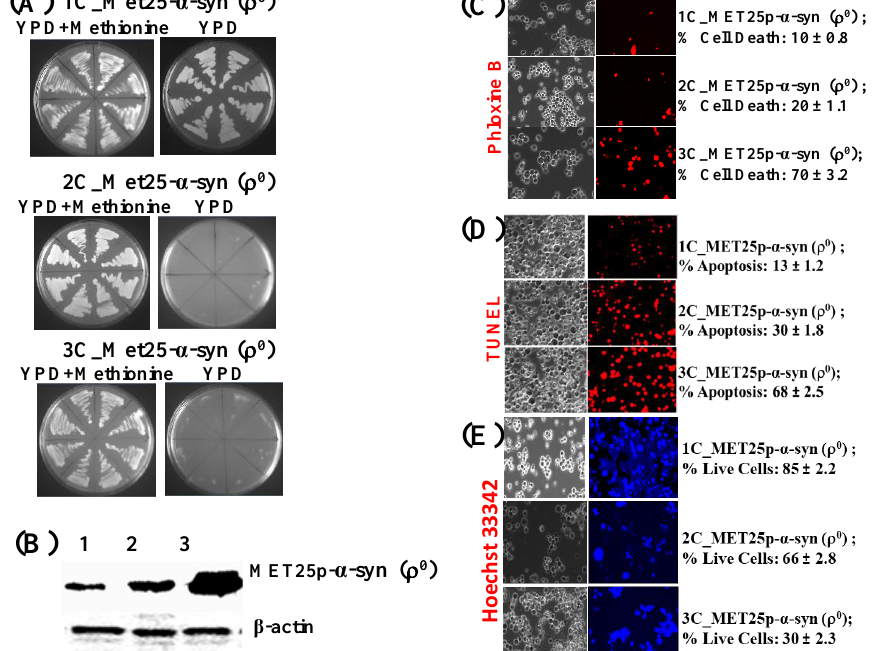
Figure 5. ( A ) Representative pictures of growth of ρ 0 yeast cells harboring 1-copy (1 C ), 2-copies (2 C ), and 3-copies (3 C ) of the human α-syn gene, under the control of either MET25 p, on complete YPD medium agar plates in the presence (YPD + Methionine) or absence (YPD) of methionine. ( B ) Western blot analyses of ρ 0 cells expressing 1-copy (lane 1), 2-copies (lane 2), and 3-copies (lane 3) of α-syn protein. On lanes 1, 2, and 3 were loaded 7.5 µg of total protein obtained after lysis of cells. The upper panel was probed with an antibody that recognizes the HA epitope (Proteintech, 51064-2-AP) and the lower panel with a β-actin antibody (Proteintech, 60008-1-Ig); levels of β-actin were used as loading controls, β-actin being a housekeeping gene. ( C ) Microscopic images (×400) of ρ 0 cells, stained with Phloxine B, after the expression of 1–3 copies of α-syn from the MET25 p. ( D ) Microscopic images (×400) of nuclear DNA fragmentation, as observed using the TUNEL assay, in ρ 0 yeast cells expressing 1–3-copies of α-syn from MET25 p. ( E ) ρ 0 cells, bearing 1–3 copies of MET25 p-driven α-syn expression cassettes, were stained with Hoechst 33,342 (a blue dye that labels DNA of live cells). Post Hoc Newman-Keuls test after a significant one-way ANOVA test, indicated a significant difference between petites expressing 1–3 copies of α-syn. The ρ 0 cells containing 1-copy of α-syn grew upon expression of the protein on a YPD plate. Cells containing 2 and 3 copies, however, did not grow, implying that comparatively lower levels of α-syn produced from 1-copy gene expression cannot block cell growth on plates. The expression of α-syn